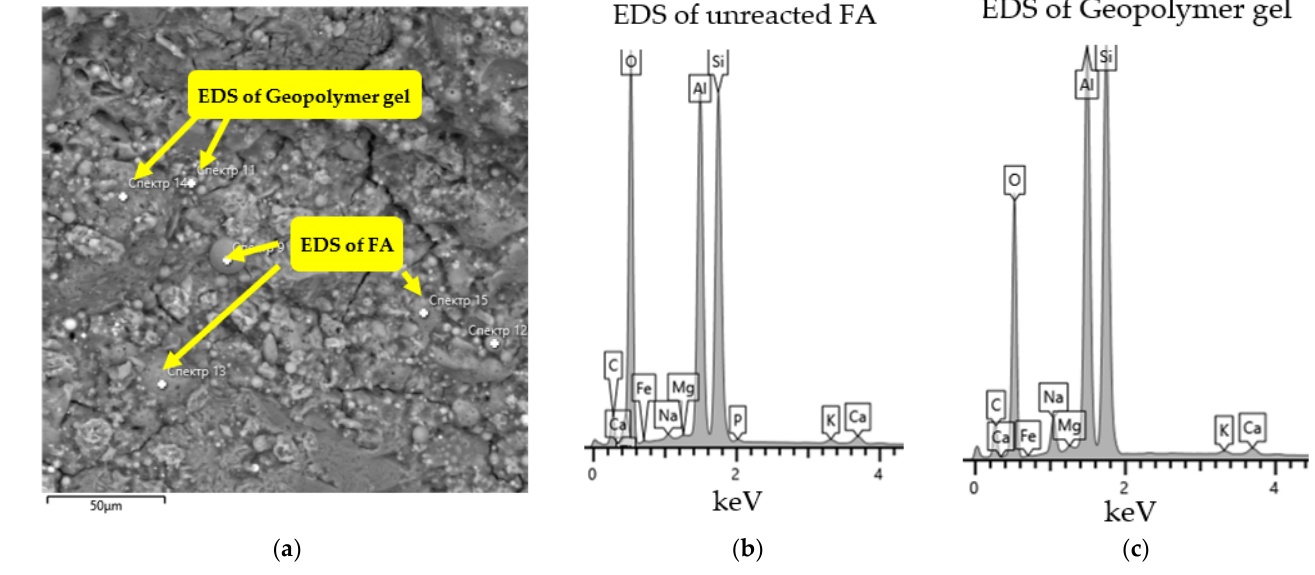
Figure 4. SEM images of Mix 1. ( a , c ) On images on the left were taken after 3 days of curing; ( b , d ) the images on the right were taken after 28 days of curing.